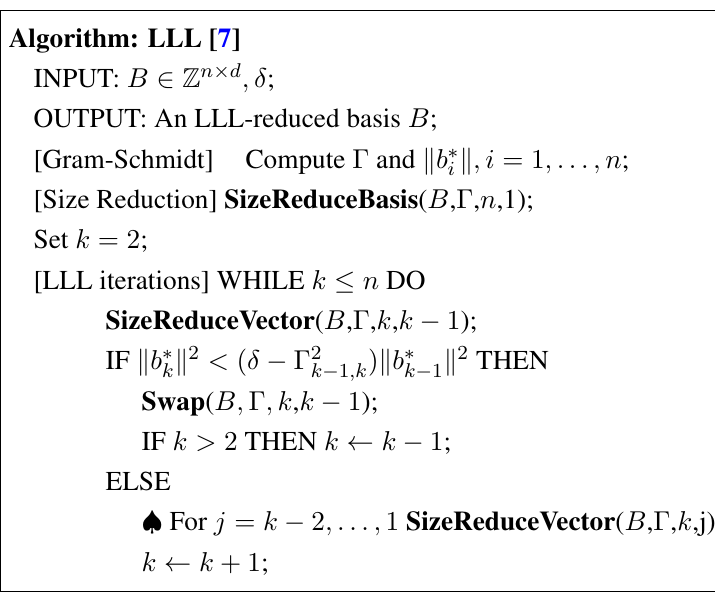
Figure 4. The LLL Basis Reduction Algorithm with Rearranged